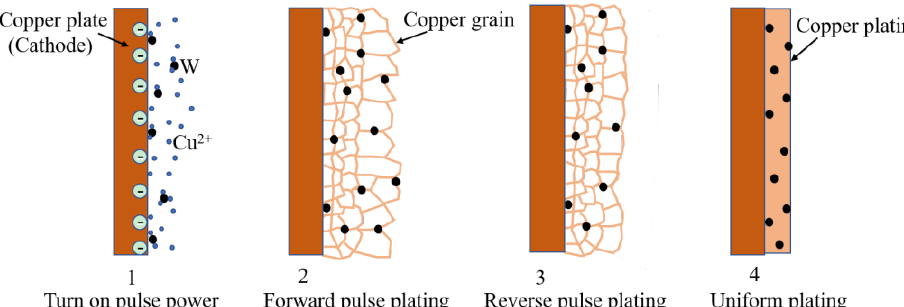
Figure 12. The densification mechanism of W–Cu composite coatings prepared by pulse electro- plating.